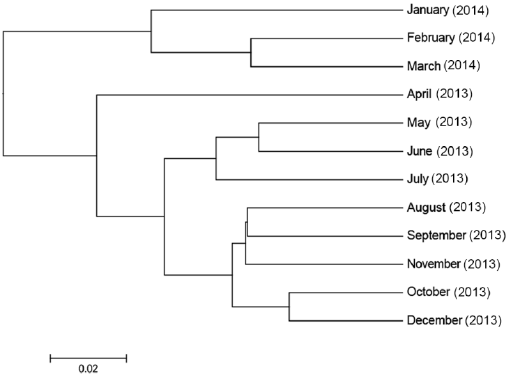
Figure 5. Month-wise hierarchical clustering of the faecal bacterial community of horses included in the study. The cladogram shows the beta diversity of the bacterial community in the faecal sam-